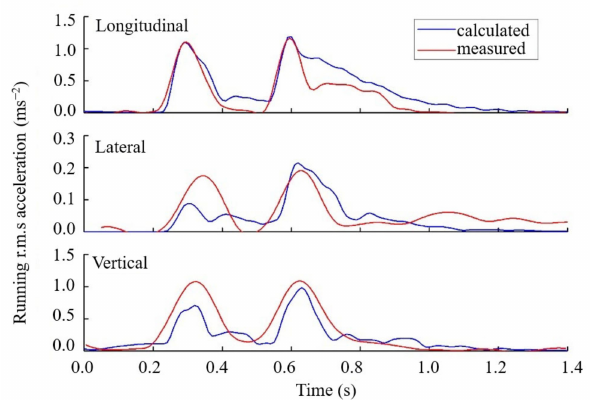
Figure 4. Comparison between calculated and measured running r.m.s acceleration at the driver seat